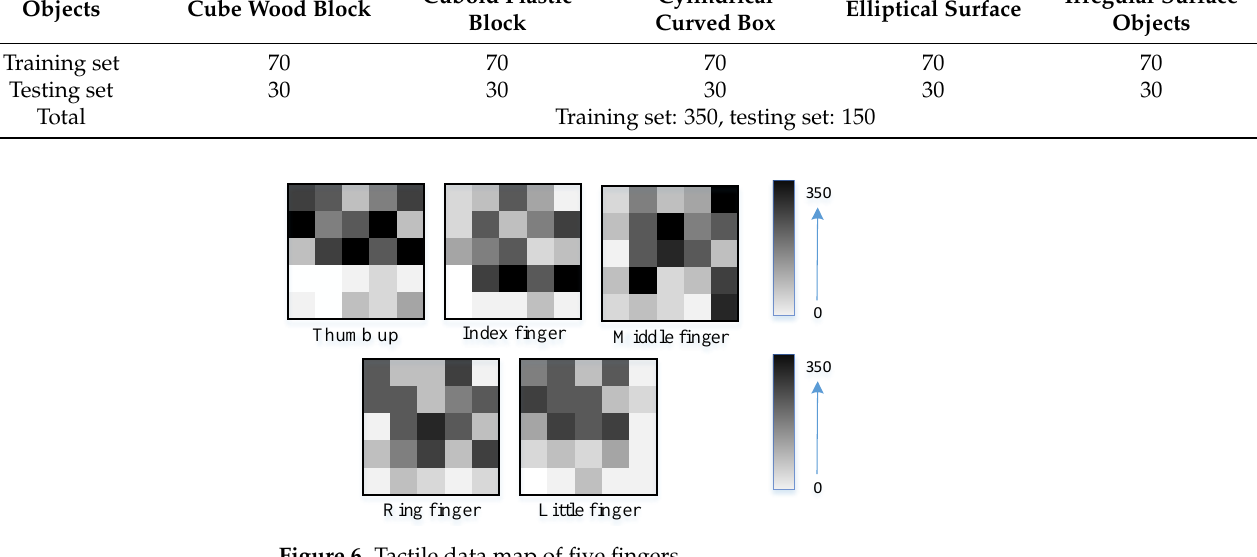
Table 1. Dataset division.